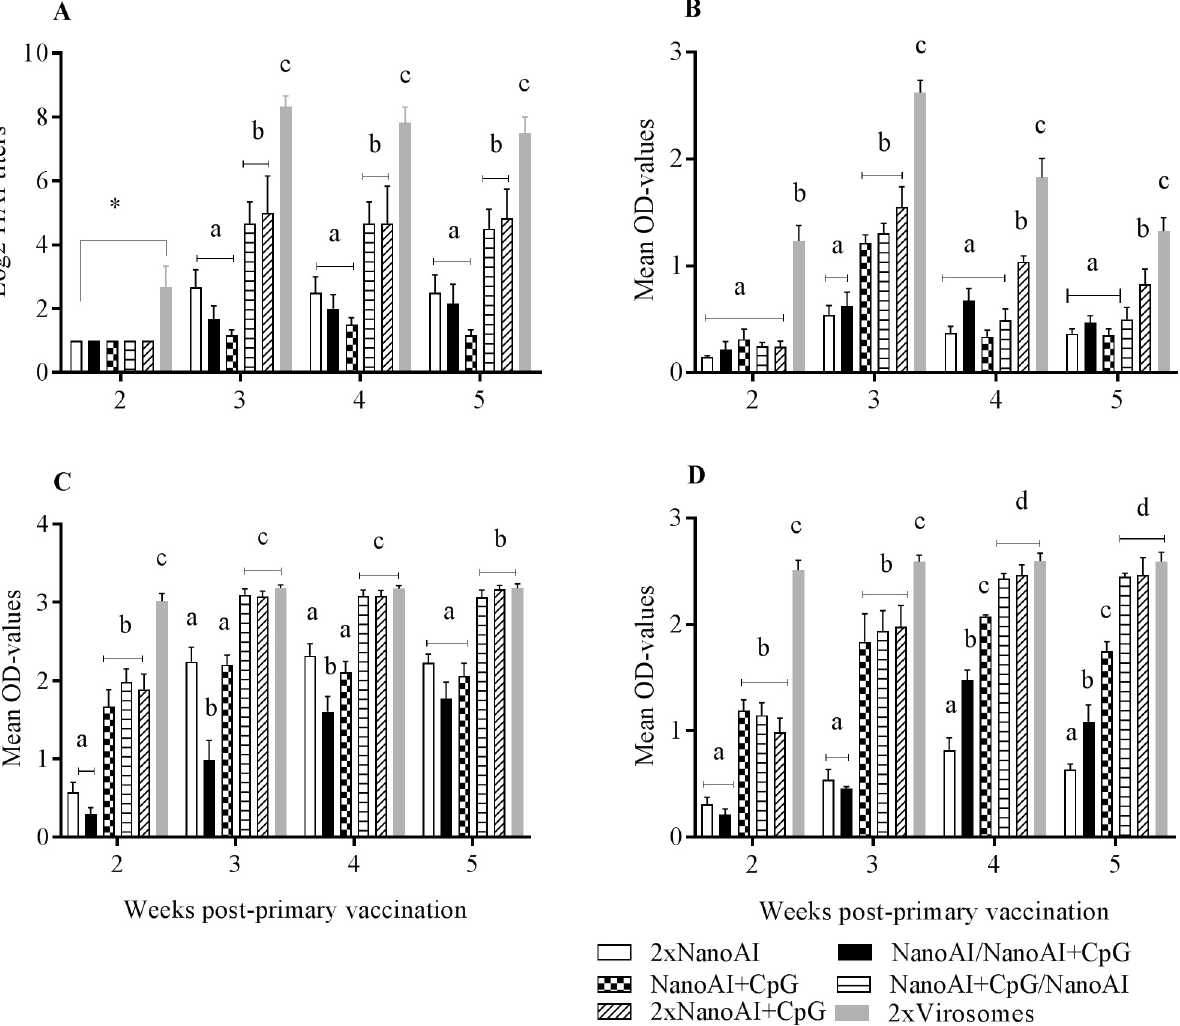
Fig 2. Serum HI (A), serum IgM (B) and IgG (C), and lachrymal IgG responses (D) . SPF chickens were vaccinated subcutaneously with PLGA NPs formulated AIV vaccines and virosomes. Serum samples and lachrymal secretions were collected weekly for antibody determination. Data shown were mean ± SEM, (n = 6/group). P < 0.05 was considered significant. Different letters within a defined single-time point show significant differences between groups, while identical letters within a defined single time point show no statistically significant differences between groups. The cut-off value for ELISA was set as the mean OD value of the Mock Nano sera plus 2 standard deviations (SD) to ensure that 95% of the OD-values for the Mock Nano sera sample fell within this range.